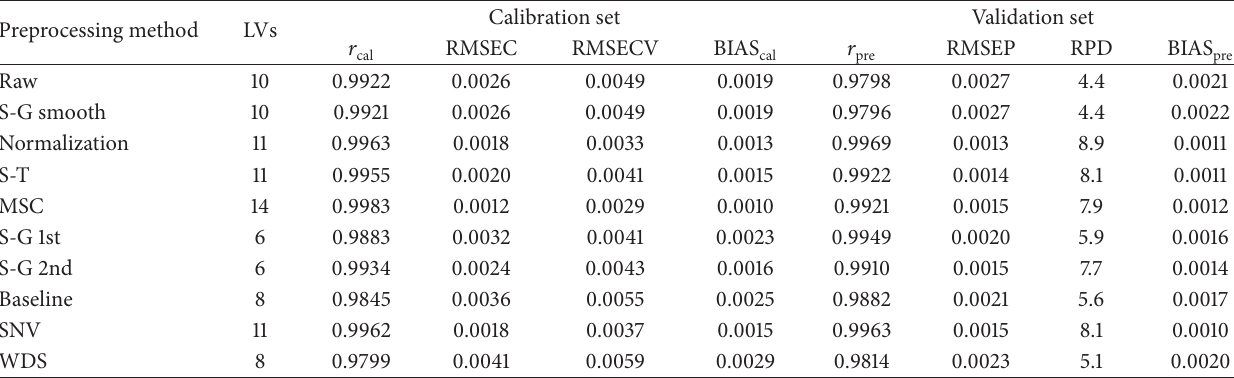
Table 6: Comparison of different preprocessing methods of partial least squares model for content of cryptotanshinone/mg ⋅ g −1 . Preprocessing method